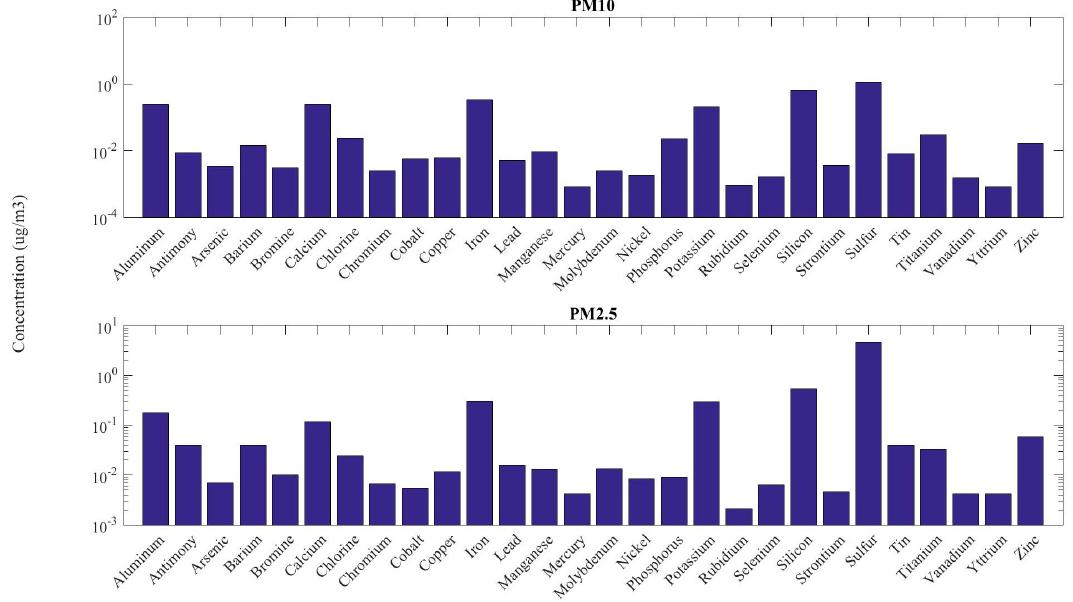
Figure 9. The results of the XRF analysis plotted on a log scale.